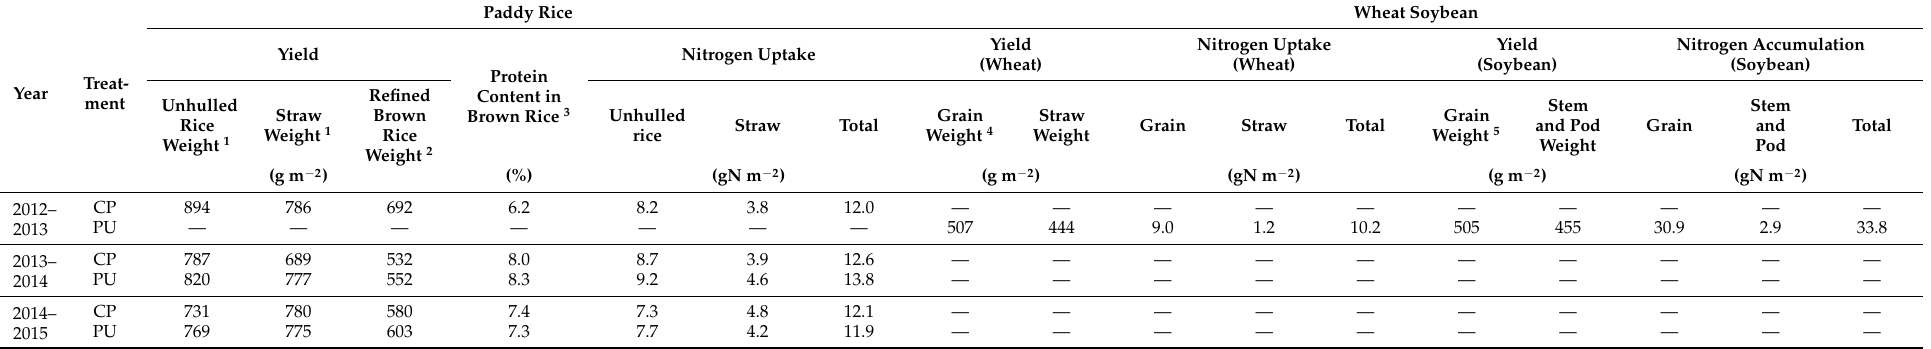
Table 4. Yield, quality and nitrogen uptake of paddy rice, wheat and